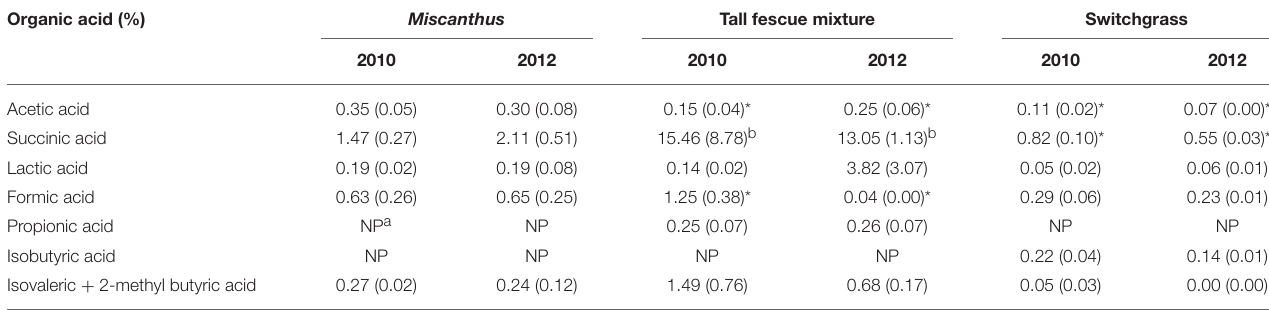
TABLE 7 | Percent of each organic acid in the water extractions of Miscanthus , the tall fescue mixture, and switchgrass grown in 2010 and 2012 [ n = 3; mean (1 SD )]. Organic acid